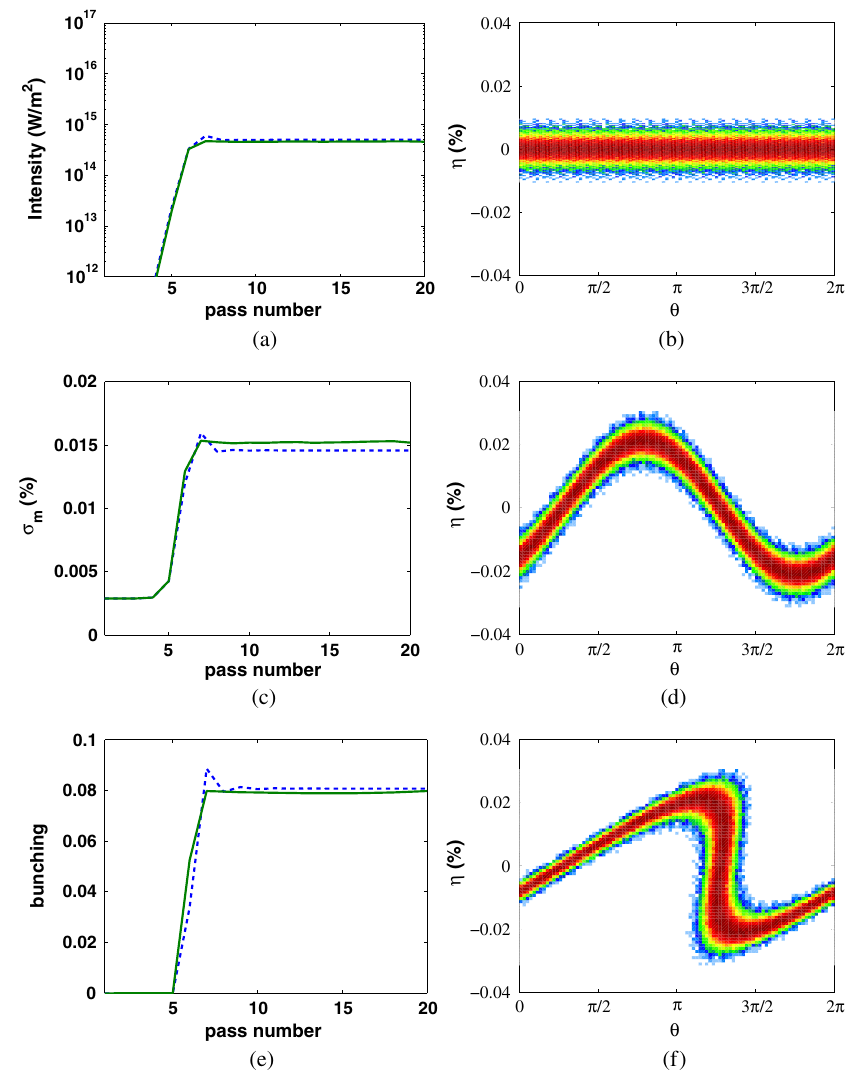
FIG. 5. A comparison of the map (dashed line) to a one-dimensional simulation (solid line), and equilibrium longitudinal phase spaces for key points along the prebunching section of the HGHG radiator-first scheme with red areas indicating higher phase space density: (a) intensity of the 13.4 nm seed radiation reaching the modulation section; (b) initial phase space of the electron beam; (c) energy spread at the exit of the modulator; (d) phase space at the end of the modulator; (e) bunching at the 10th harmonic after the chicane; and (f) phase space after